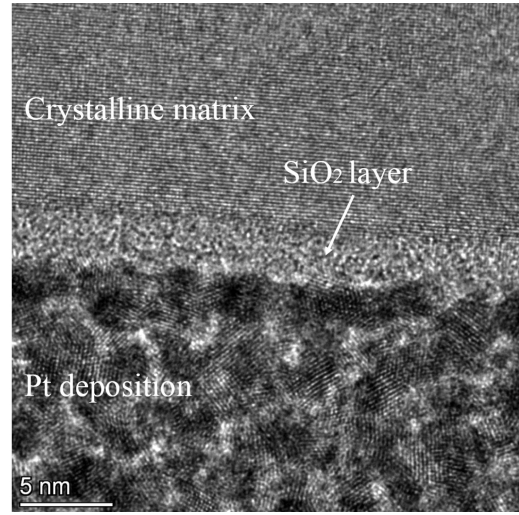
Figure 7 Cross-section HRTEM image of the polishing CC workpiece. A three- tiered structure is displayed: the bottom is made of Pt deposition, the middle is an SiO 2 layer, and the top is crystalline